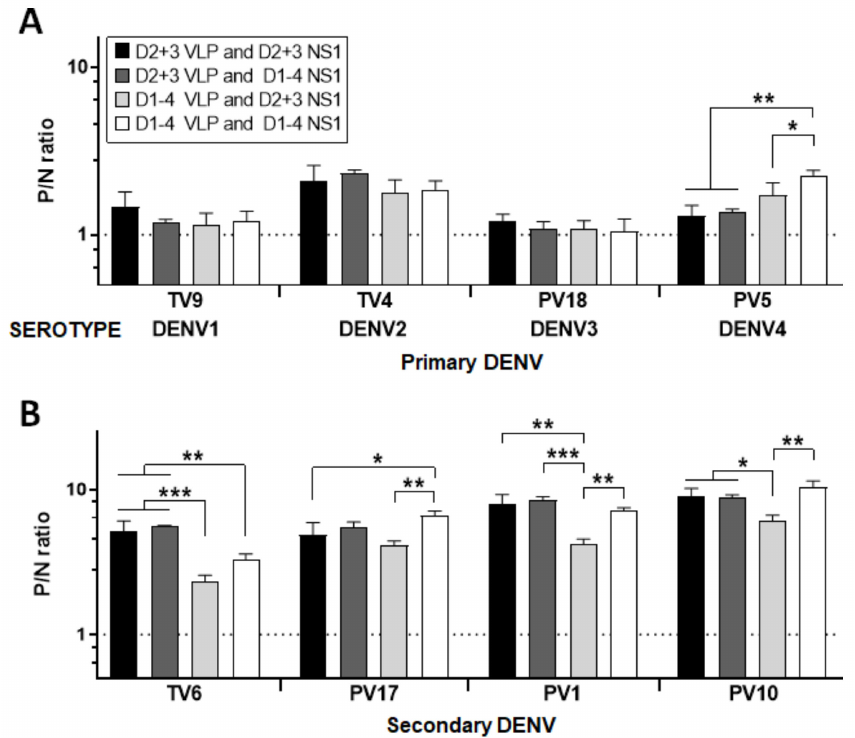
Figure 3. Determination of the optimal antigen combinations for NS1 GAC–ELISA. Anti-prM/E antibodies in community serum samples were predepleted using a combination of DENV2 + 3 VLP antigens only or DENV1–4 VLP antigens before performing the GAC–ELISAs. Both combination strategies were similarly applied for the NS1 antigens in the subsequent GAC–ELISAs of sera coming from four volunteers with primary ( A ) DENV1 to 4 infections and from four volunteers with secondary ( B ) DENV infections. The dotted lines indicate the P/N ratio of negative control serum. All data were obtained from three independent experiments with duplicates, and the standard deviations are indicated by error bars. Means were analyzed by one-way ANOVA and statistical significance is indicated with asterisk (*, p < 0.05; **, p < 0.01; ***, p <